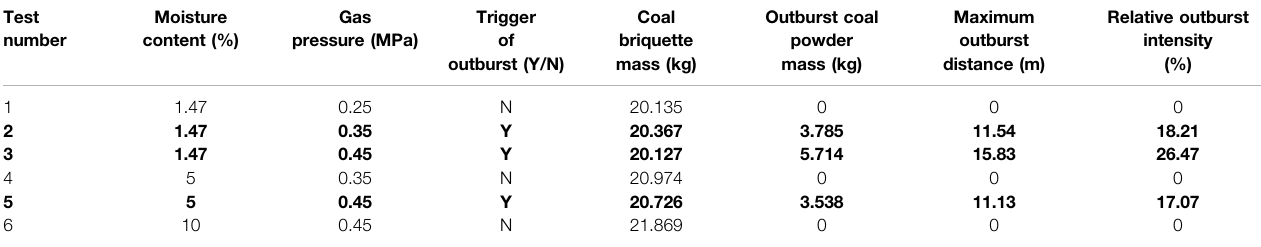
The bold values indicate that the coal and gas outburst was triggered in this group test.